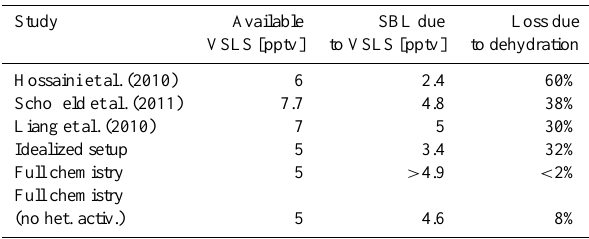
Table 4. Overview of the contribution of VSLS to stratospheric bromine loading (SBL) and the impact of dehydration in different modeling studies. The columns give the average tropical mixing ratio of available bromine in the form of VSLS and the stratospheric bromine loading due to VSLS. The ratio of both values represents the loss of bromine due to